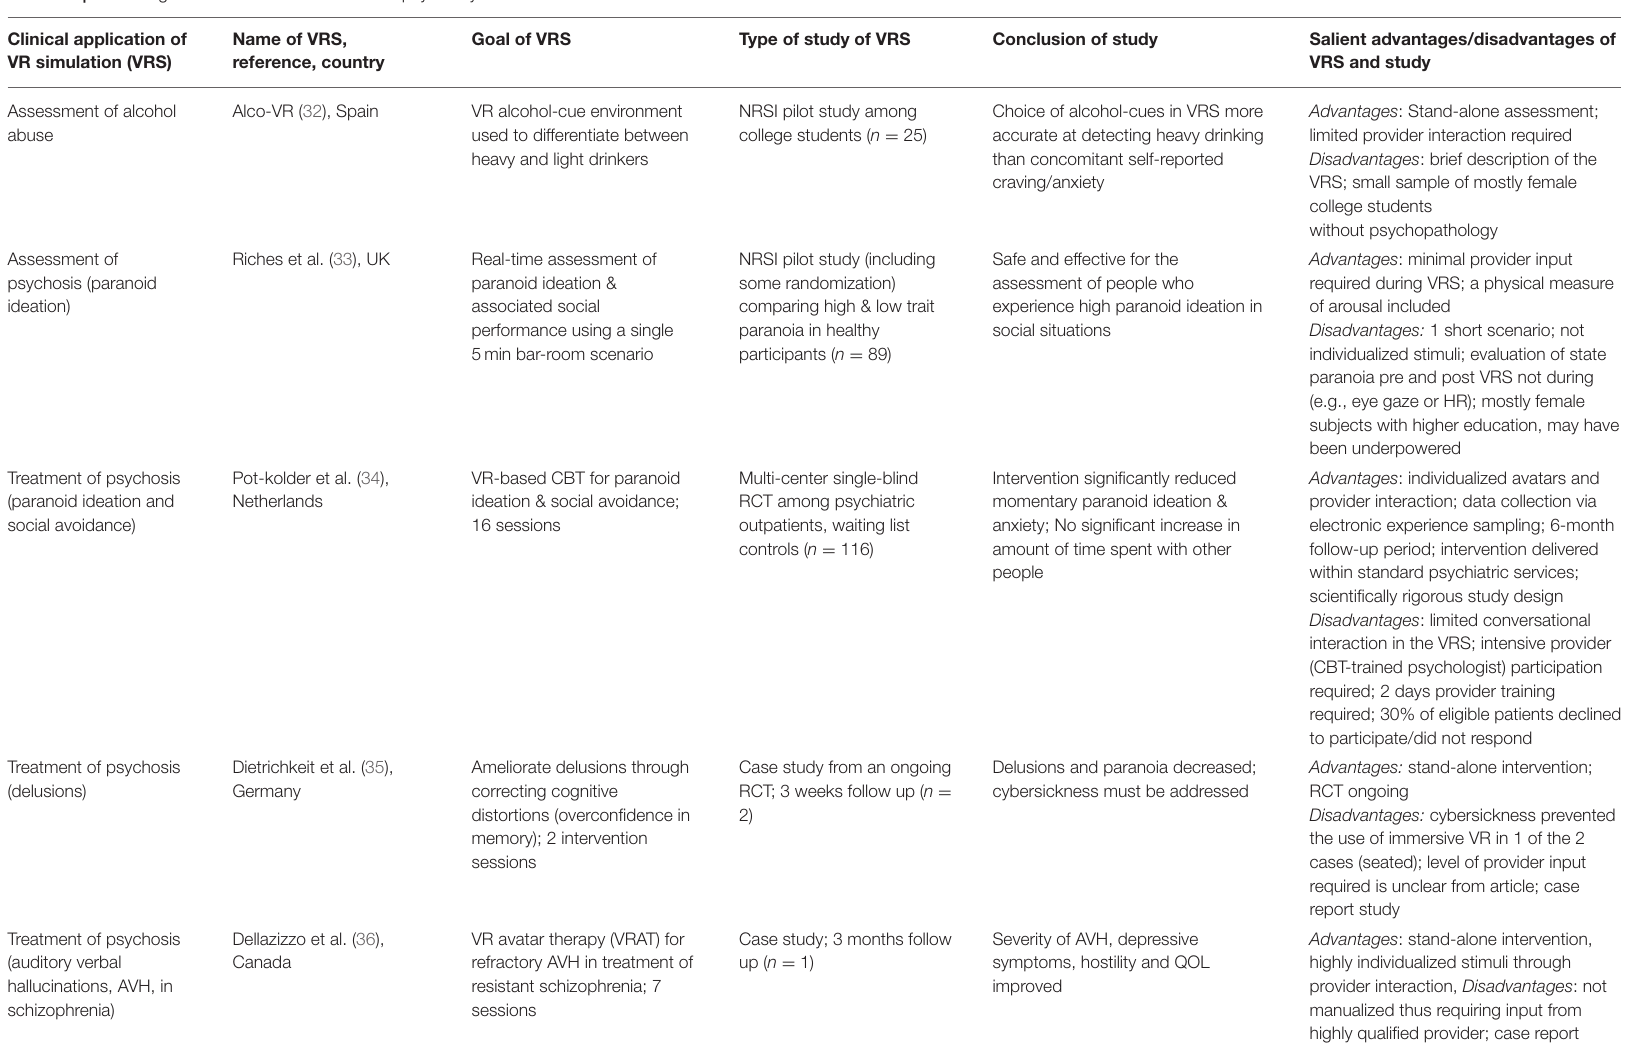
TABLE 2 | VR in diagnostic areas related to forensic